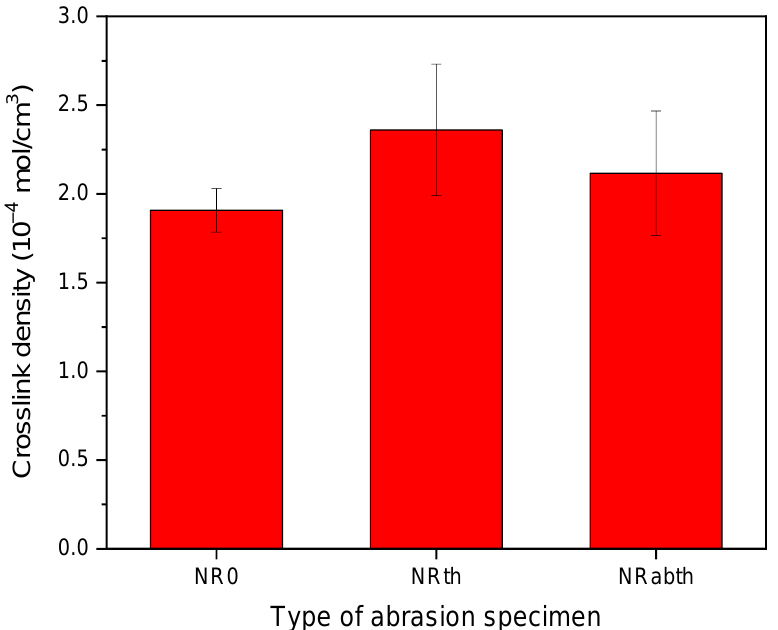
Figure 2. Crosslink densities of the abrasion specimens.